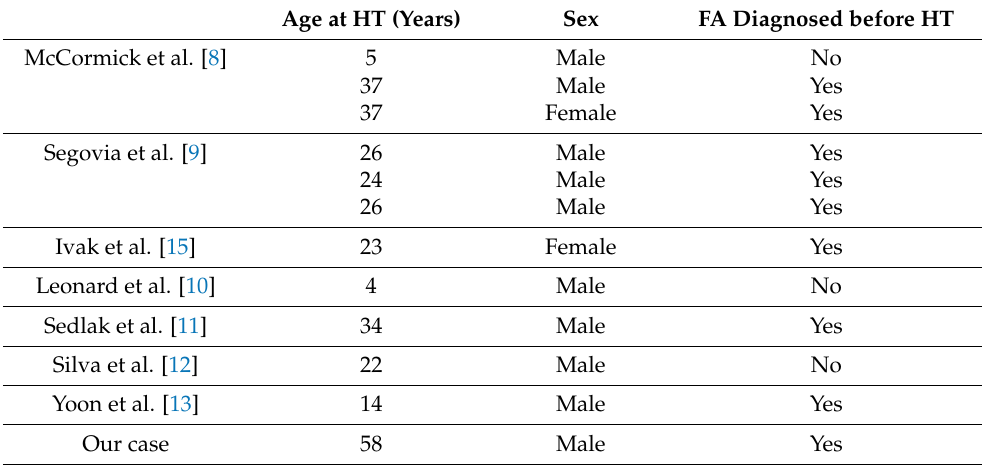
Table 1. Cases of Freidereich’s ataxia (FA) patients treated with heart transplant